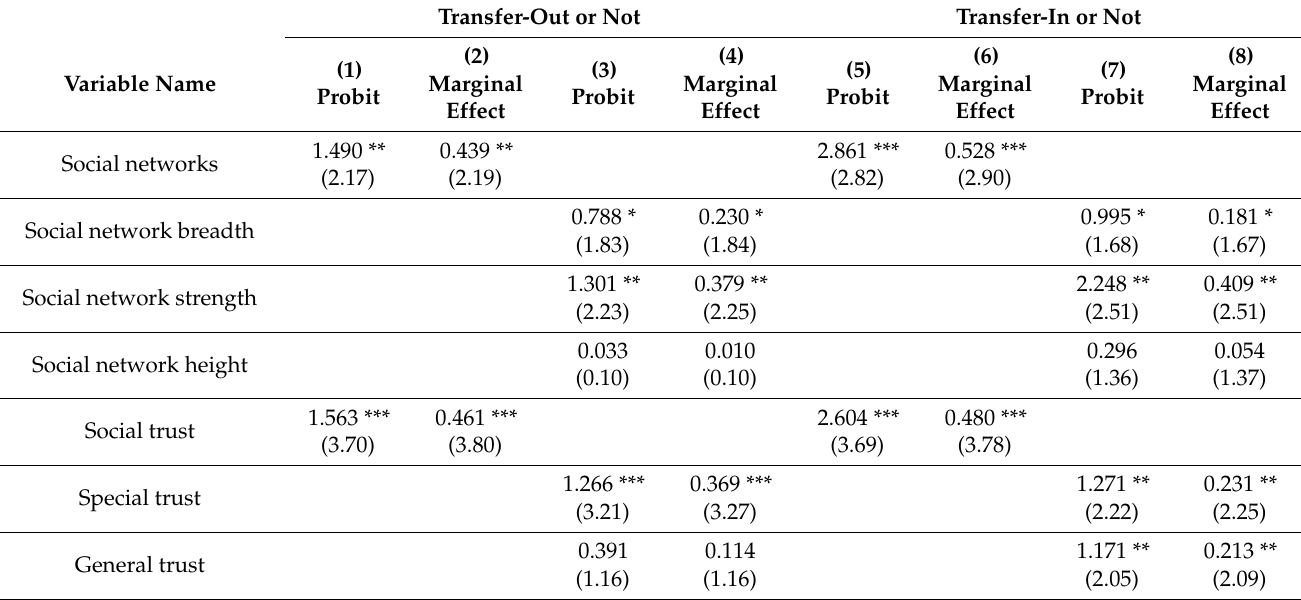
Table 3. Impact of social capital on farmland transfer decision. Transfer-Out or Not Transfer-In or